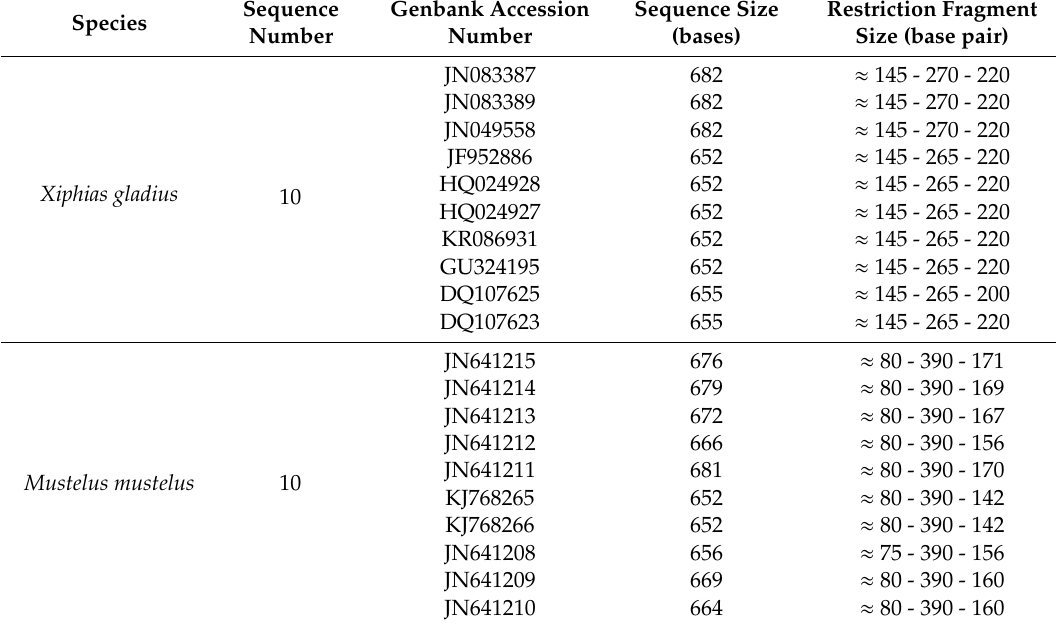
Figure 1. Flow chart of COIBar–RFLP (cytochrome oxidase I barcode–restriction fragment length polymorphism) or species discrimination. DNA barcoding steps: DNA isolation from swordfish slices and barcode region PCR amplification. In silico analysis steps: search for an appropriate restriction enzyme. RFLP steps: incubation of barcode amplicons with Mbo I to obtain the COIBar–RFLP pattern. ML, maximum likelihood; nBLAST, nucleotide Basic Local Alignment Search Tool. Table 2. In silico analysis of swordfish and shark COI sequences scanned by Remap and using MboI as restriction endonuclease.